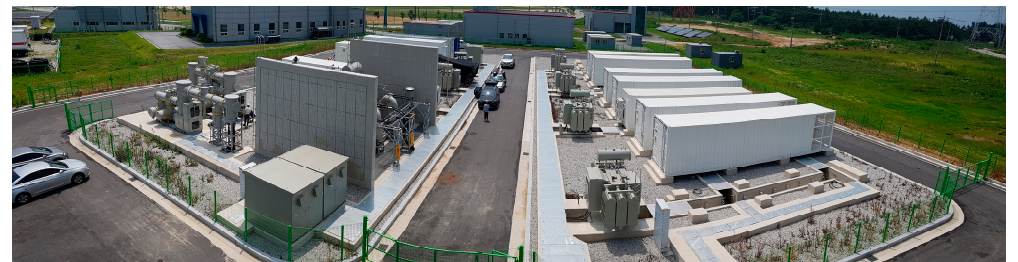
Figure 11. KEPCO Gochang BESS demonstration system.